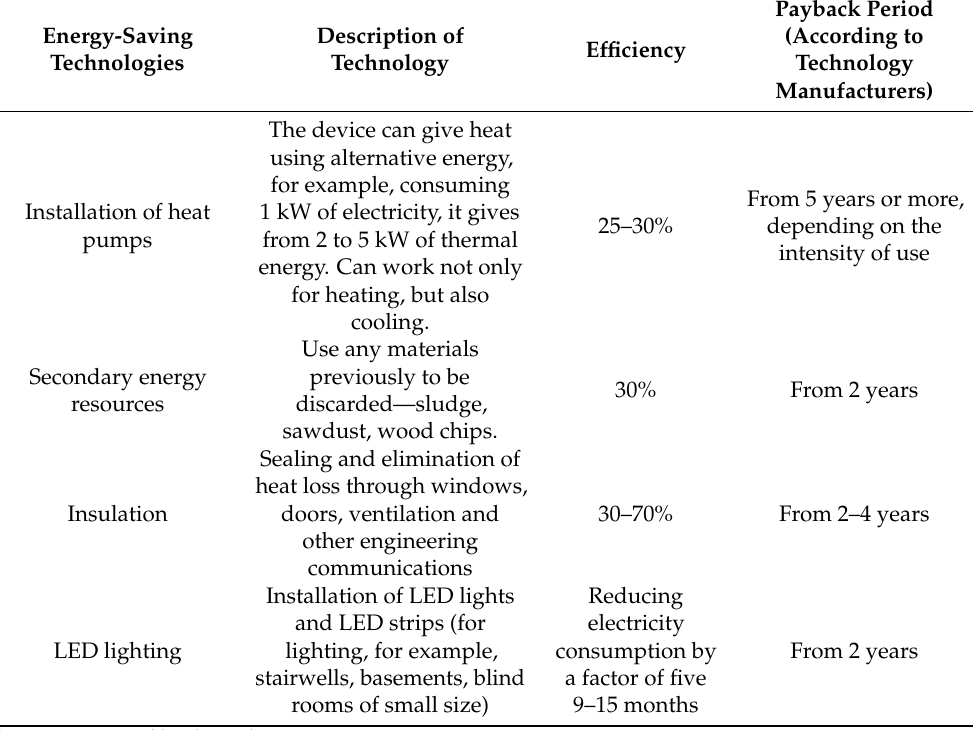
Table 5. Energy-saving technologies for the housing and communal services sector.